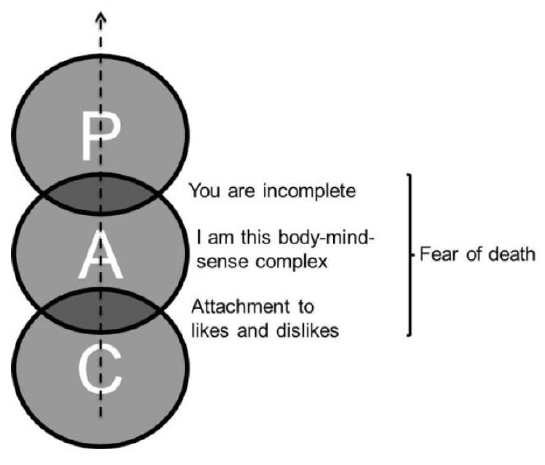
Figure 19: Spiritual Contamination and Fear of Death (Suriyaprakash & Geetha, 2014, p.342)